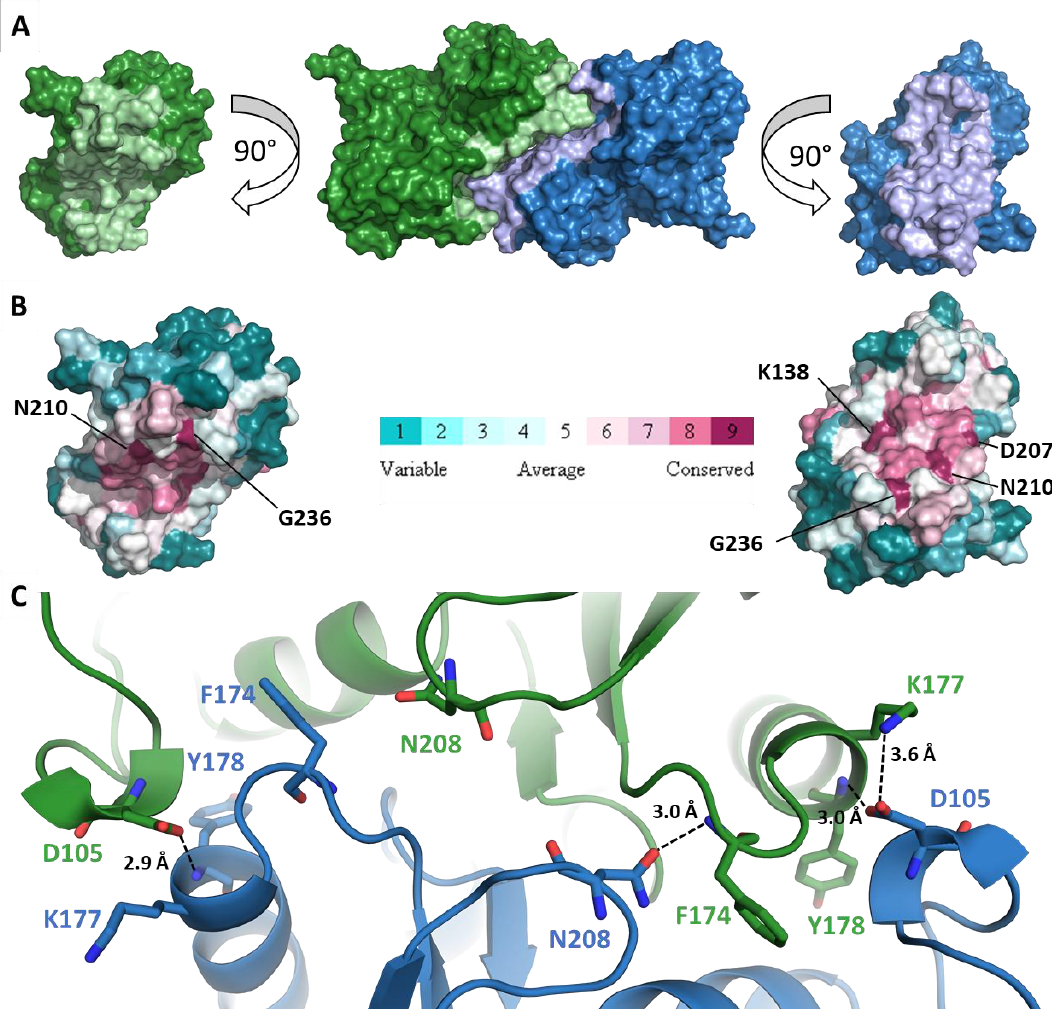
Figure 3. CrRPI1 homodimerization. ( A ) From left to right, Connolly solvent exclusion surface representation of subunit A, dimer and subunit B of CrRPI1. Subunit A is colored in green, and subunit B in blue. Residues composing the interface between the two subunits are colored in light green and light blue for subunits A and B respectively. ( B ) Surface residues conservation of subunits A and B as calculated with CONSURF colored from teal (least conserved) to purple (most conserved). Most conserved residues of the interface are annotated. ( C ) Cartoon representation of the dimer interface. Residues in bonding distances are represented in stick and annotated. Polar contacts are traced with black dashed lines with interatomic distances indicated in Ångström (Å).